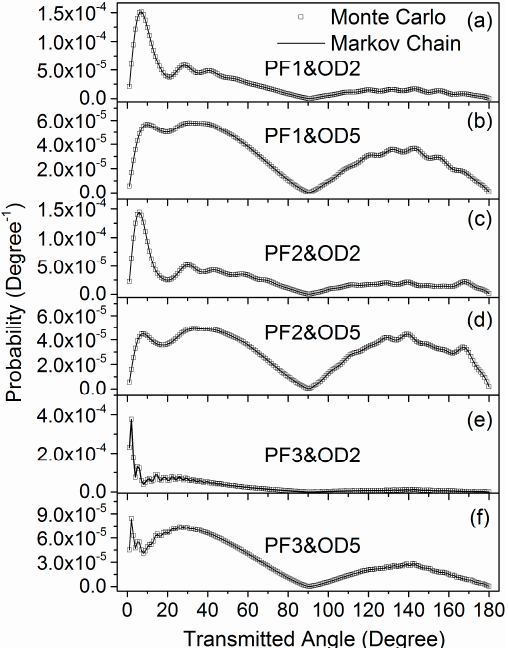
Figure 3. Markov chain angular distribution predictions compared with Monte Carlo. Panel ( a ). Phase function 1, OD = 2; Panel ( b ). Phase function 1, OD = 5; Panel ( c ). Phase function 2, OD = 2; Panel ( d ). Phase function 2, OD = 5; Panel ( e ). Phase function 3, OD = 2; Panel ( f ). Phase function 3, OD =